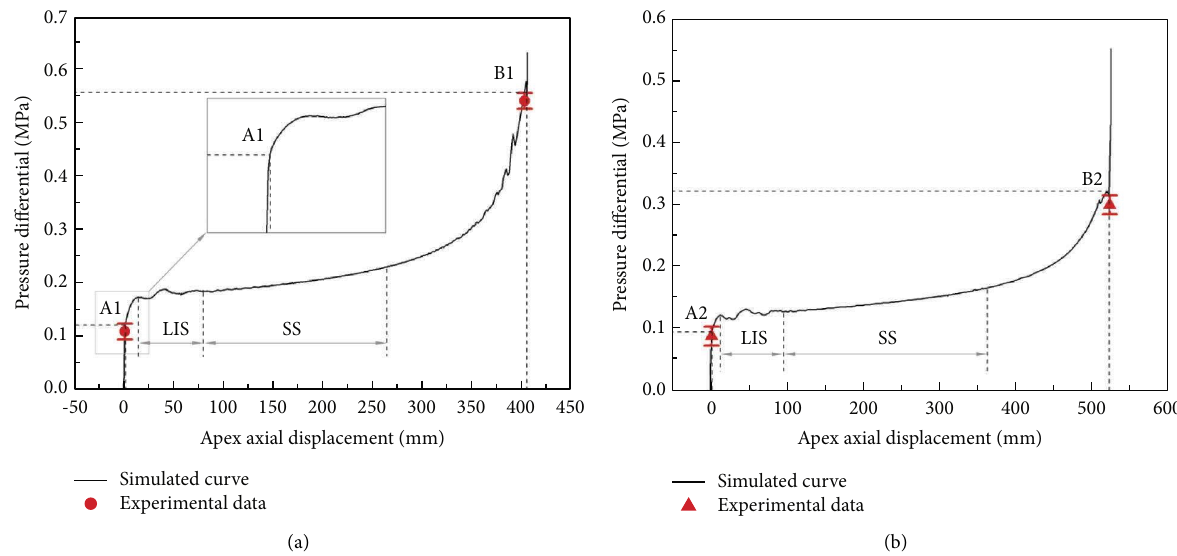
Figure 8: Plastic fow stress curve used in the FE model.